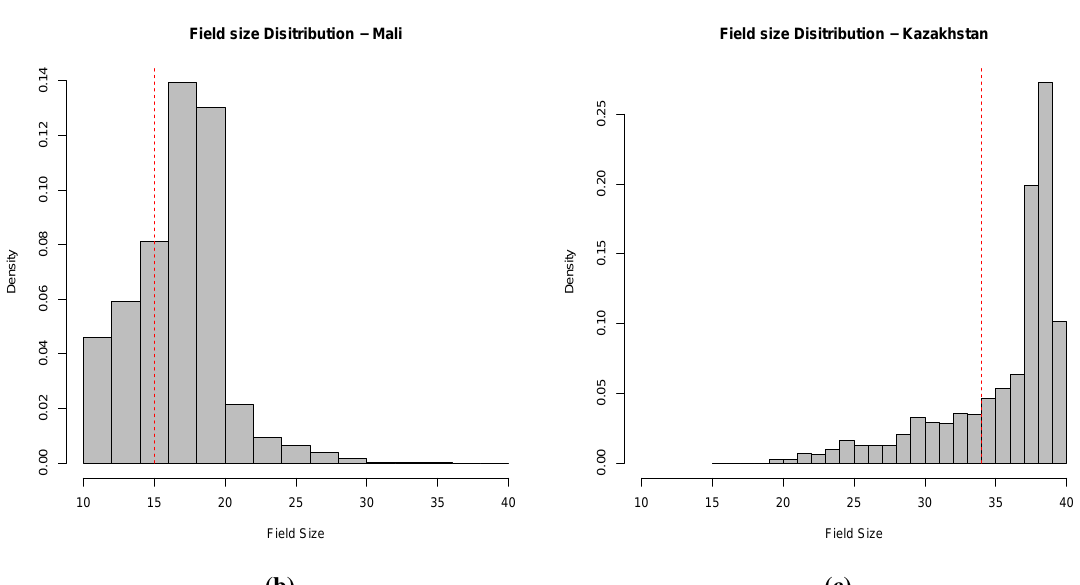
Figure 2. Global distribution of field size per country and histograms of the field size distribution for two contrasted countries. Note that the result is provided in arbitrary units (very small = 10, small = 20, medium = 30 and large = 40). ( a ) First quartile field size category, ( b ) Field size distribution of a small field size country, ( c ) Field size distribution of a medium parcel size